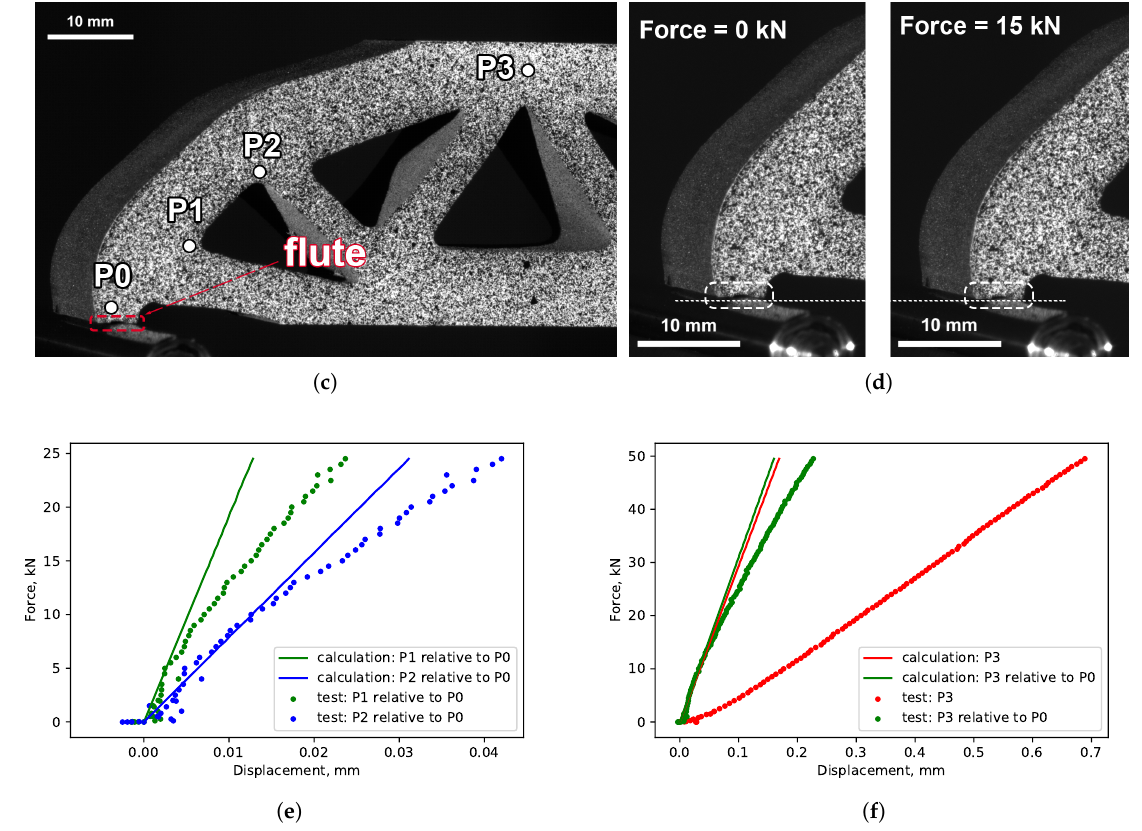
Figure 9. ( a ) The manufactured part attached to the cylindrical substrate. ( b ) The image from Digital Image Correlation System. ( c ) The location of tracked points on the part. ( d ) The test photos of the part under loads 0 and 15 kN. ( f ) The test and calculation results of vertical displacement for points P1 and P2. ( e ) The test and calculation results of vertical displacement for point